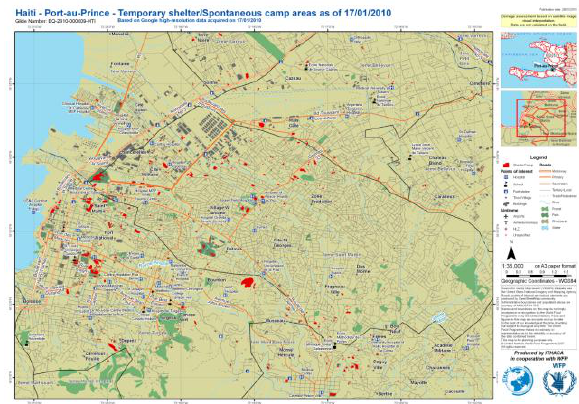
Figure 5. Haiti – Port-au-Prince: temporary shelter/spontaneous camp as of 17 Jan 2010 (based on 0.15 m imagery) During the Haiti earthquake response phase, just few products were based on SAR data, e.g. a 2D Ground Motion based on TerraSAR-X data produced by DLR/ZKI and a multi-temporal coherence analysis based on COSMO-SkyMED data